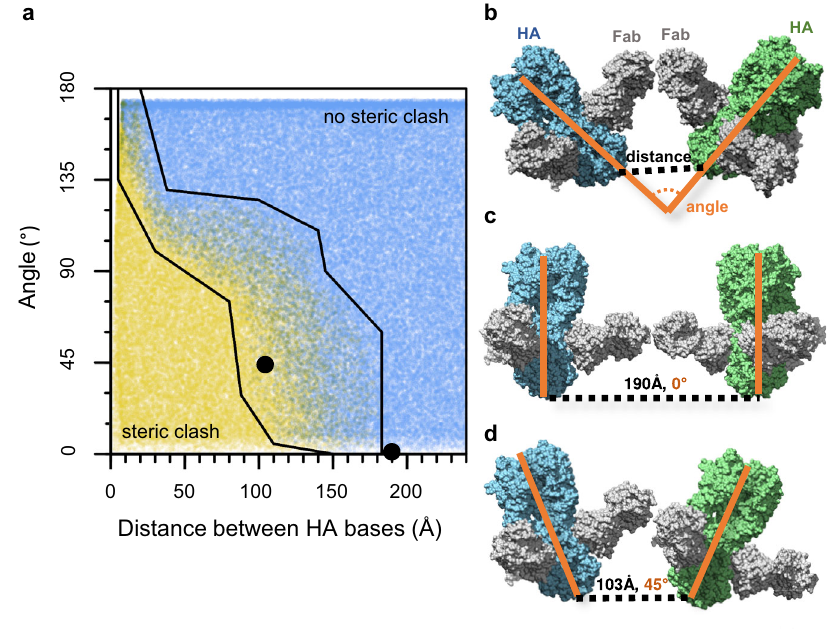
Fig. 2 | Monte Carlo model relating HA orientation with occlusion of stem antibody binding. a Structures of pairs of HA-trimers (green and blue), each with threestemFabsboundincomplex(gray),wererandomlyorientedbyrigidrotation relative to each other, and then the resulting complexes were scored for steric clash.Thestericclashesweredescribedaccordingtothedistancebetweenthebase of HA trimers, and the angle between the central axis of HA trimers (orange line). The plot of steric clashes was empirically segmented into three regions: no steric clash (blue), all steric clash (yellow), and conditional steric clash depending upon theinterdigitationofFabs(mixtureofblueandyellow).Withinthecentralregionof